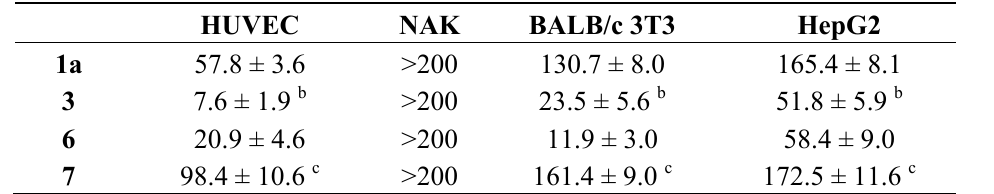
Table 2. Effect of selected compounds on viability of endothelial cells (HUVEC), keratinocytes (NAK), fibroblasts (BALB/c 3T3) and hepatoma epithelial cells (HepG2) a